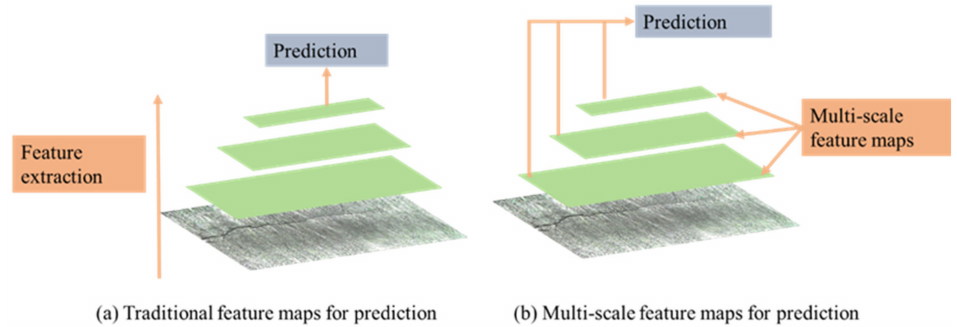
Figure 5. Multi-scale crack feature maps for detection.